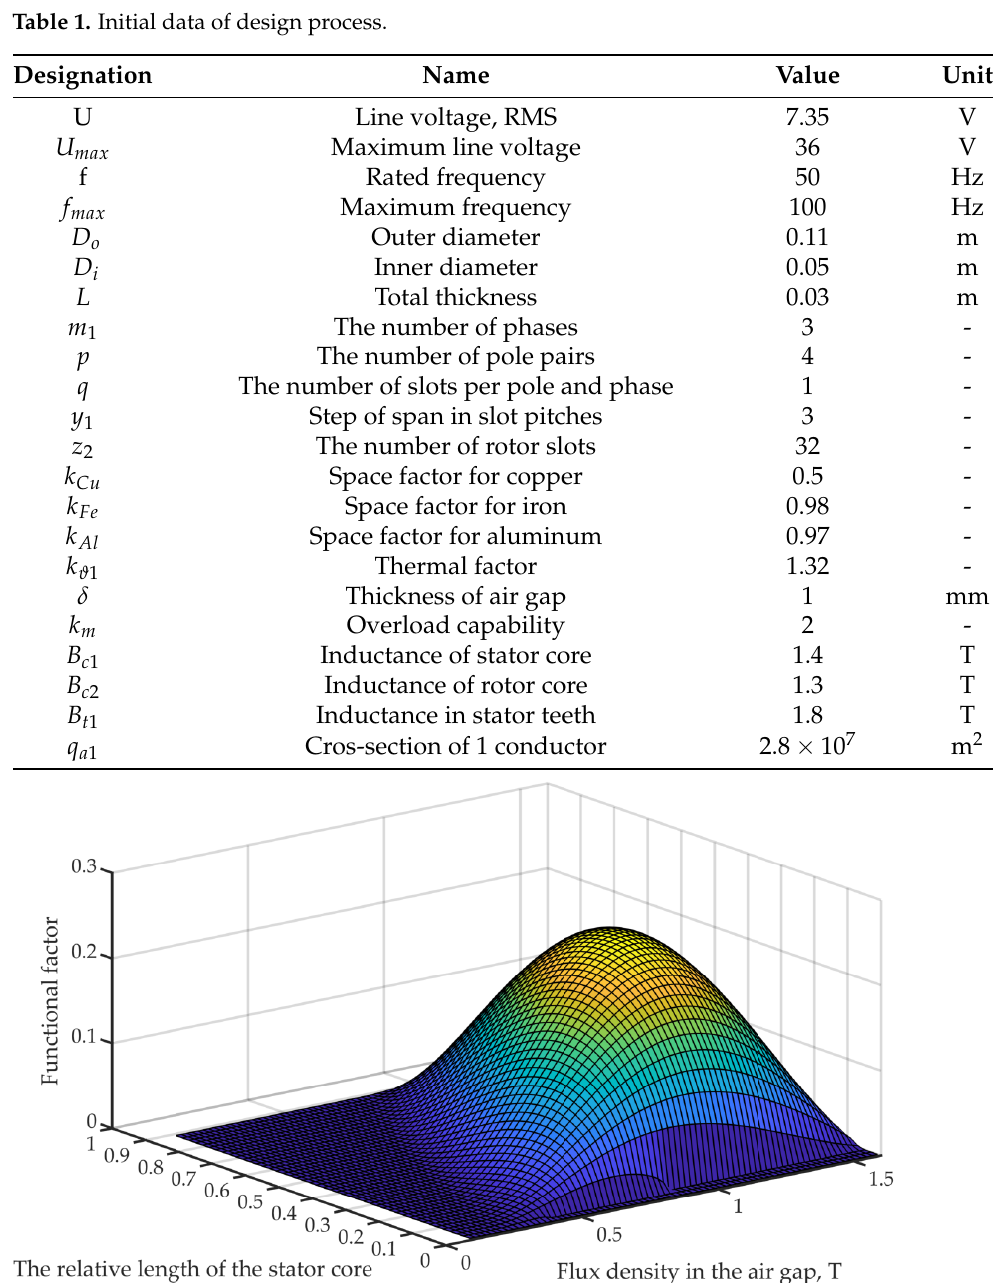
Figure 4. Constraints determining electromagnetic